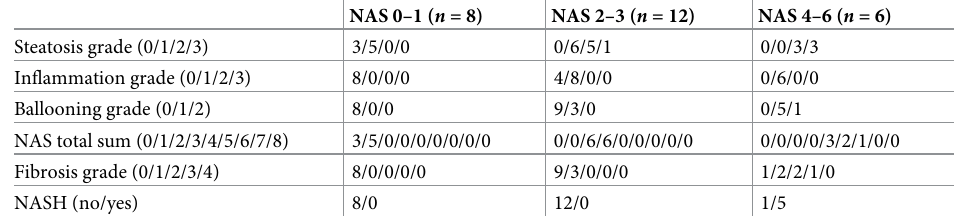
Table 2. Frequency table of NAS, fibrosis grade and NASH of study participants divided into three groups with increasing NAS.